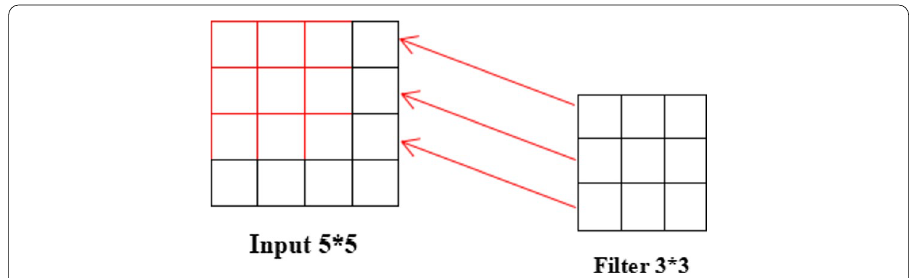
Fig. 4 Schematic diagram of image convolution